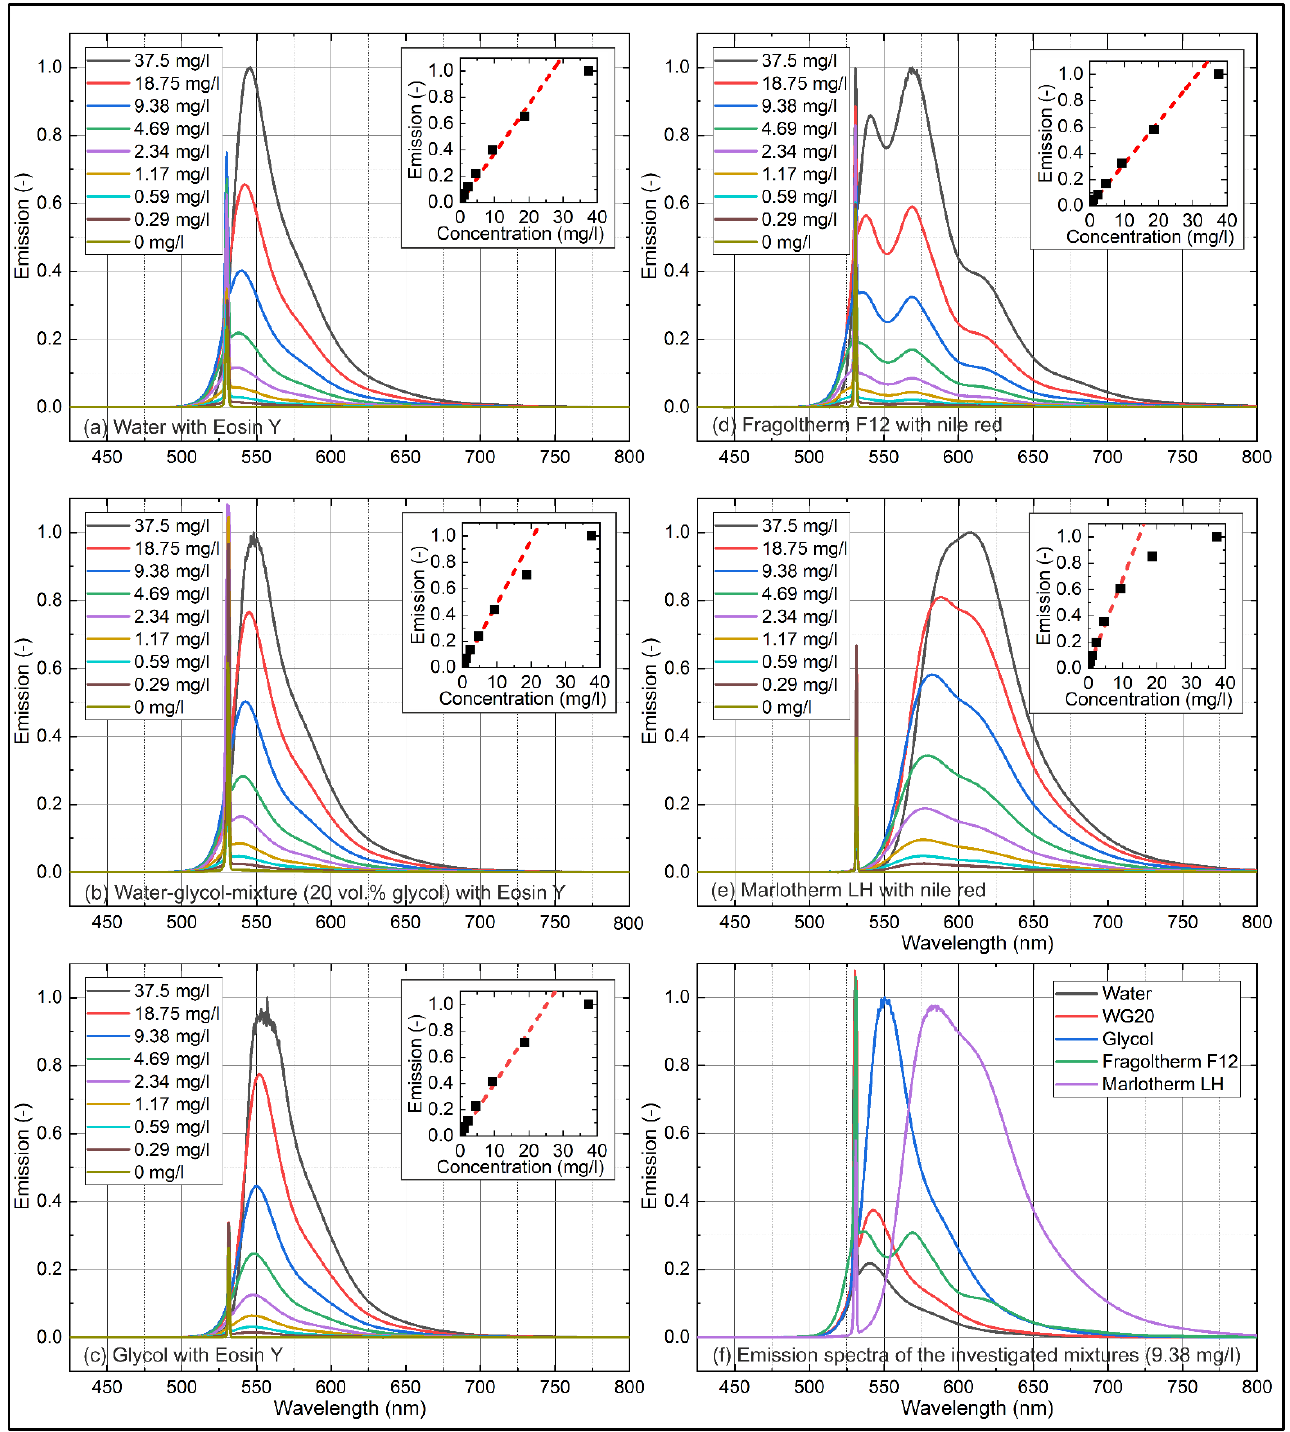
Figure 3. Concentration-dependent emission spectra of Eosin-Y ( a – c ) and Nile red ( d , e ) in various solvents; comparison of various liquids at a fixed tracer concentration of 9.38 mg/L ( f ), 293